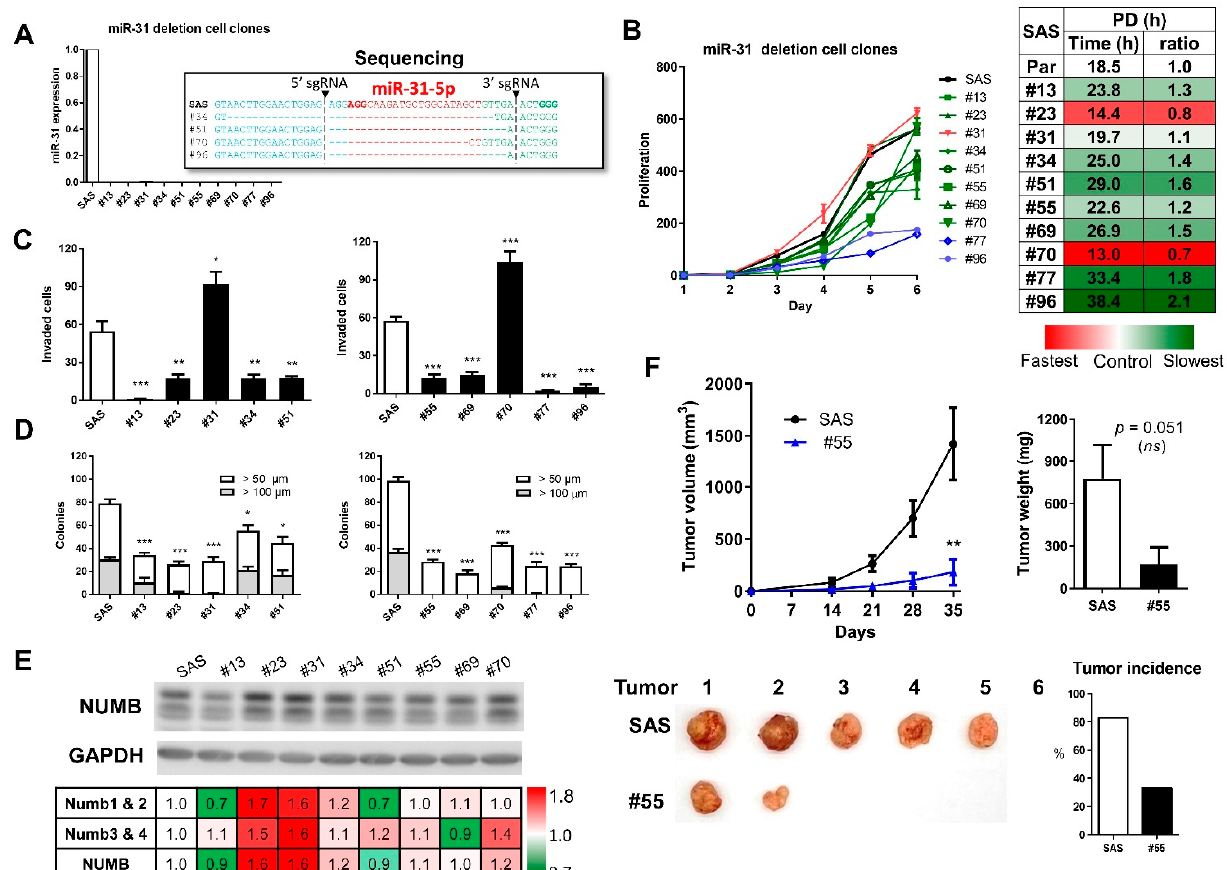
Figure 1. miR-31 deletion suppresses OSCC oncogenicity. ( A ) qRT-PCR analysis of miR-31 expression in representative subclones revealed the complete absence of miR-31 expression. Representative sequencing results, shown in the indent, demonstrated the truncation of miR-31 -5p segments in the subclones. miR-31 expression levels and the truncation of miR-31 -5p in other subclones are shown in Figure S1B,C. ( B , C ) Growth and invasion assays. The right panel of ( B ) is a heatmap illustrating the population doubling time of subclones. Growth or invasion was reduced in 8 of the 10 subclones. PD, population doubling time (h). ( D ) Anchorage-independent colony formation. Anchorage-independent growth was decreased in all subclones. ( E ) Upper panel, Western blot analysis of NUMB expression in subclones relative to parental cells. Lower panel, heatmap illustrating the expression levels. Upper bands, the signals of Numb1 and Numb 2 isoforms. Lower bands, the signals of Numb3 and Numb4 isoforms. NUMB signals were increased in the analyzed subclones except for #13 and #51. ( F ) Tumorigenicity of subclone #55. Upper left panel, the growth curve measured weekly. Upper right panel, the tumor weight at week 5. Lower left panel, the images of harvested tumors. Lower right panel, the incidence of tumor induction. ns , not significant; *, p < 0.05; **, p < 0.01; ***, p < 0.001.